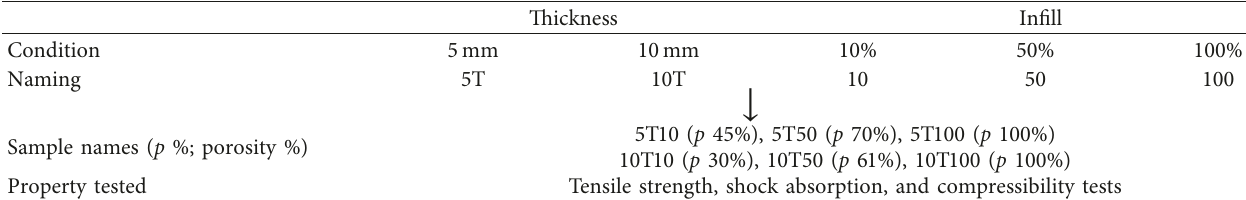
Table 2: Variables for experimental samples and properties